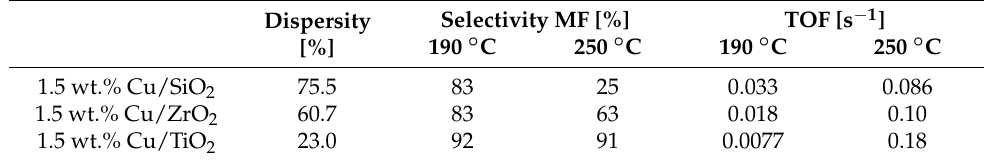
Table 2. Influence of carrier material on MF selectivity, TOF and Cu dispersity depending on reaction temperature